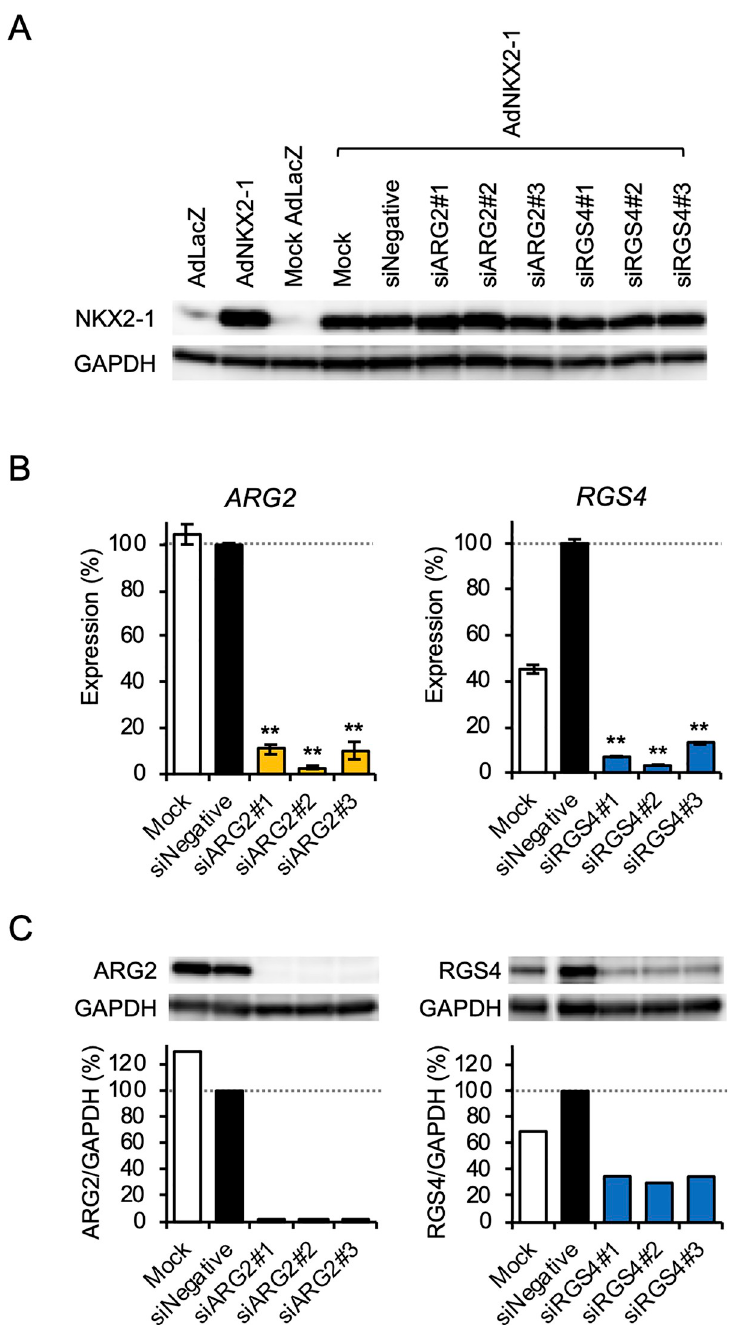
Fig 5. ARG2 and RGS4 expression in siRNA-transfected cells after AdNKX2-1 infection. (A) Western blots showing NKX2-1 and GAPDH expression 72 h after infecting BHP18-21v cells with and without siRNA transfection with 300 MOI AdLacZ or AdNKX2-1. ’Mock’ represents the Opti-MEM 1 Medium and Lipofectamine TM RNAiMAX exposed, but not siRNA transfected cells. (B) ARG2 and RGS4 mRNA expressions in siARG2- and siRGS4-transfected cells, respectively, are shown in percent of control (n = 4). siNegative-transfected cells were used as the control. All the siRNAs, #1, #2, and #3, targeting ARG2 and RGS4 efficiently downregulated each of the gene expressions. Error bars indicate SEM. �� p < 0.01, significant differences between siNegative and siARG2 or siRGS4. (C) Western blot showing ARG2 and RGS4 expression 72 h after 300 MOI AdNKX2-1 infection. The ratios (%) of protein expression in the siRGS4#1–#3-transfected cells compared with that in siNegative-transfected cells are shown.